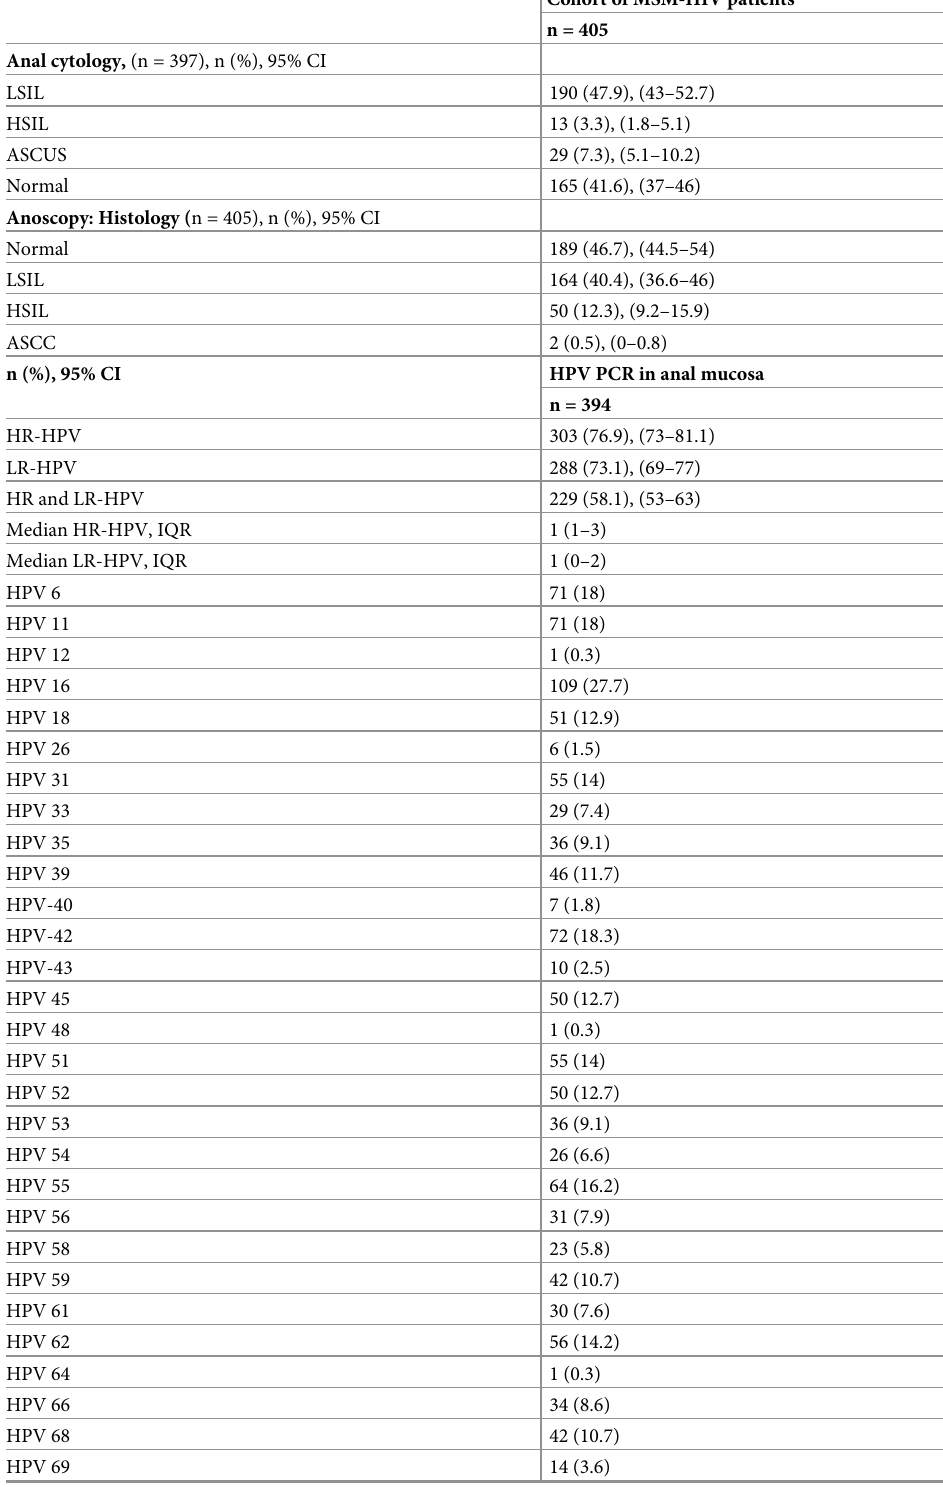
Table 2. Cytology, anoscopy, and HPV PCR results for the